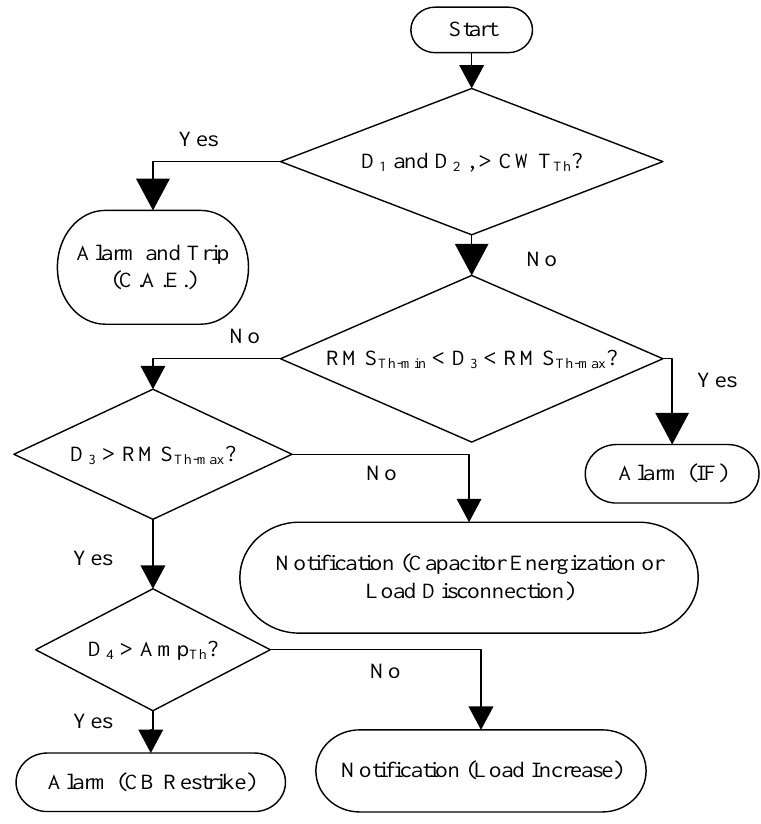
Figure 14. Decision-Tree classification process flowchart.